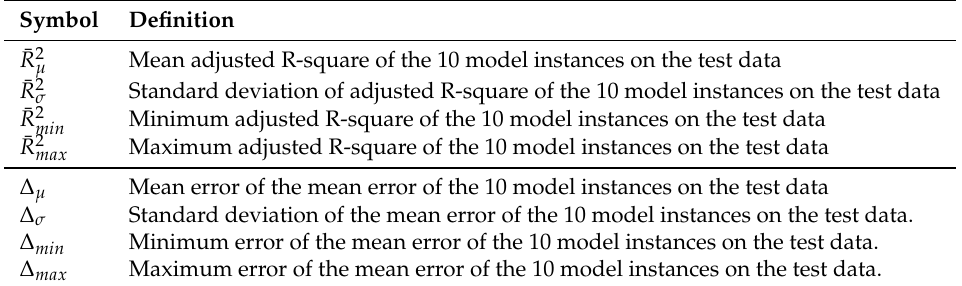
Table 8. The metrics used to evaluate the performance of each model